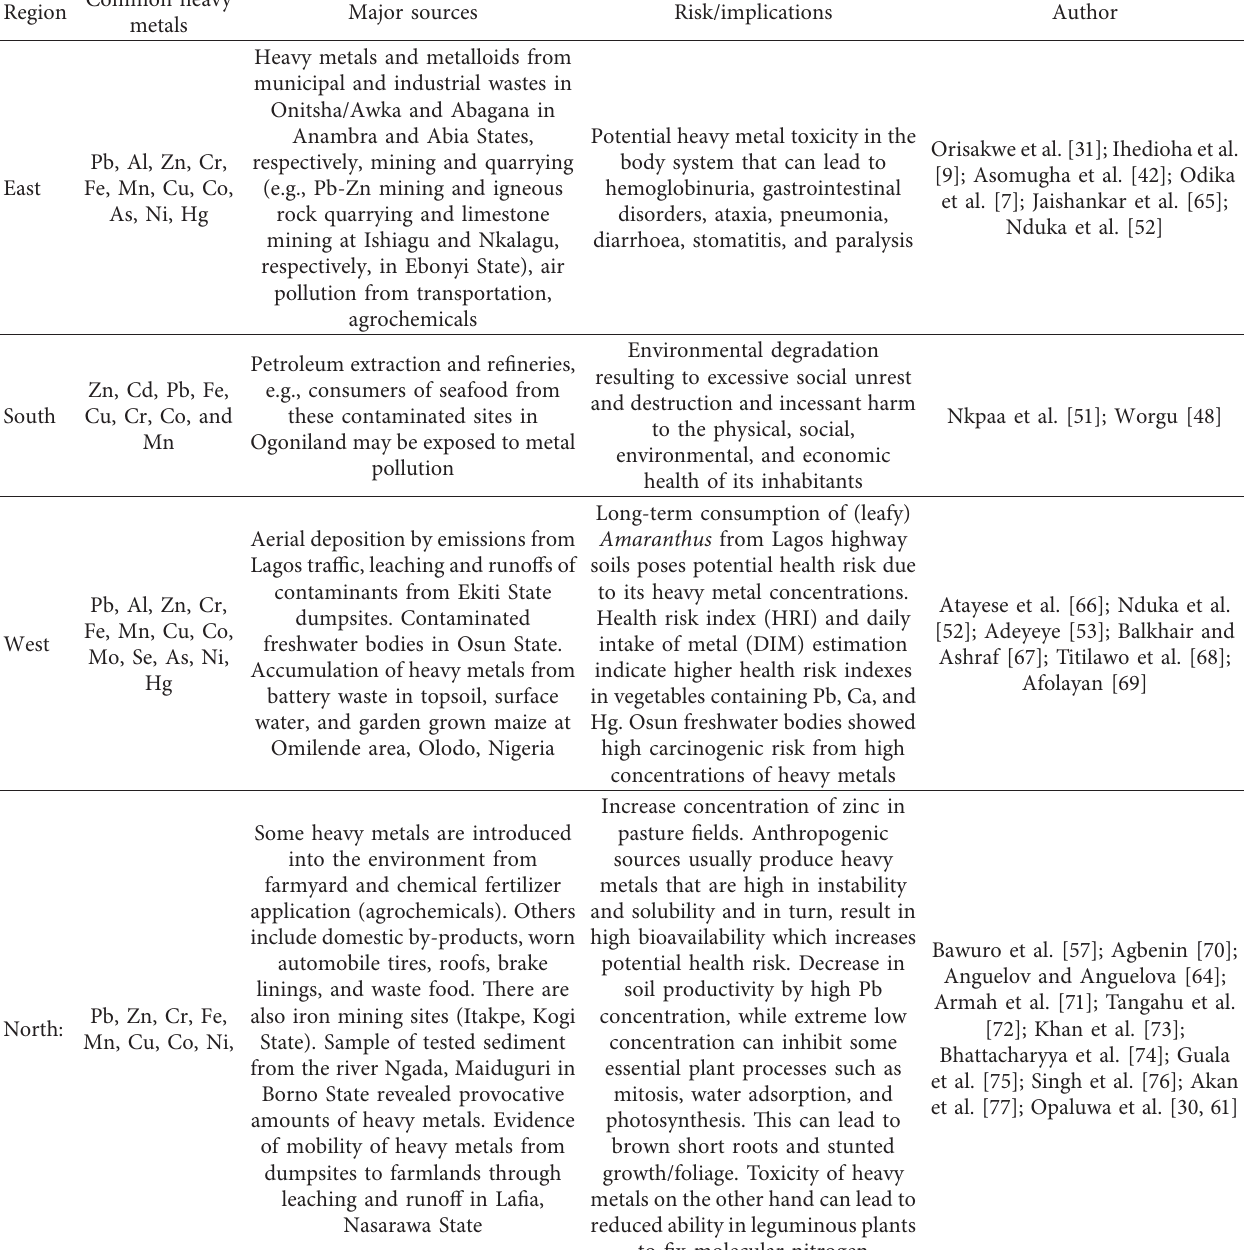
Table 2: Risk/implications of food chain contamination for humans, domestic life, and wildlife in Nigeria. Common heavy Region